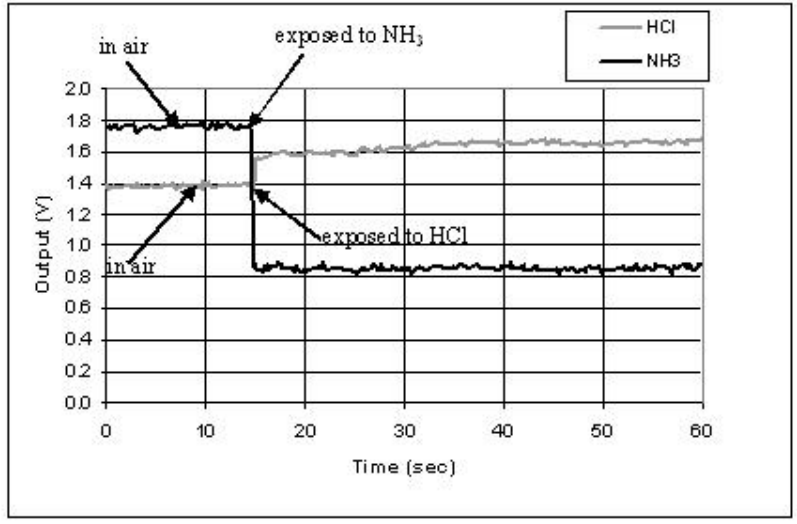
Figure 12. Sensor response to chemical vapors of HCl and NH polyaniline by in-situ deposition. The deposition time was 30